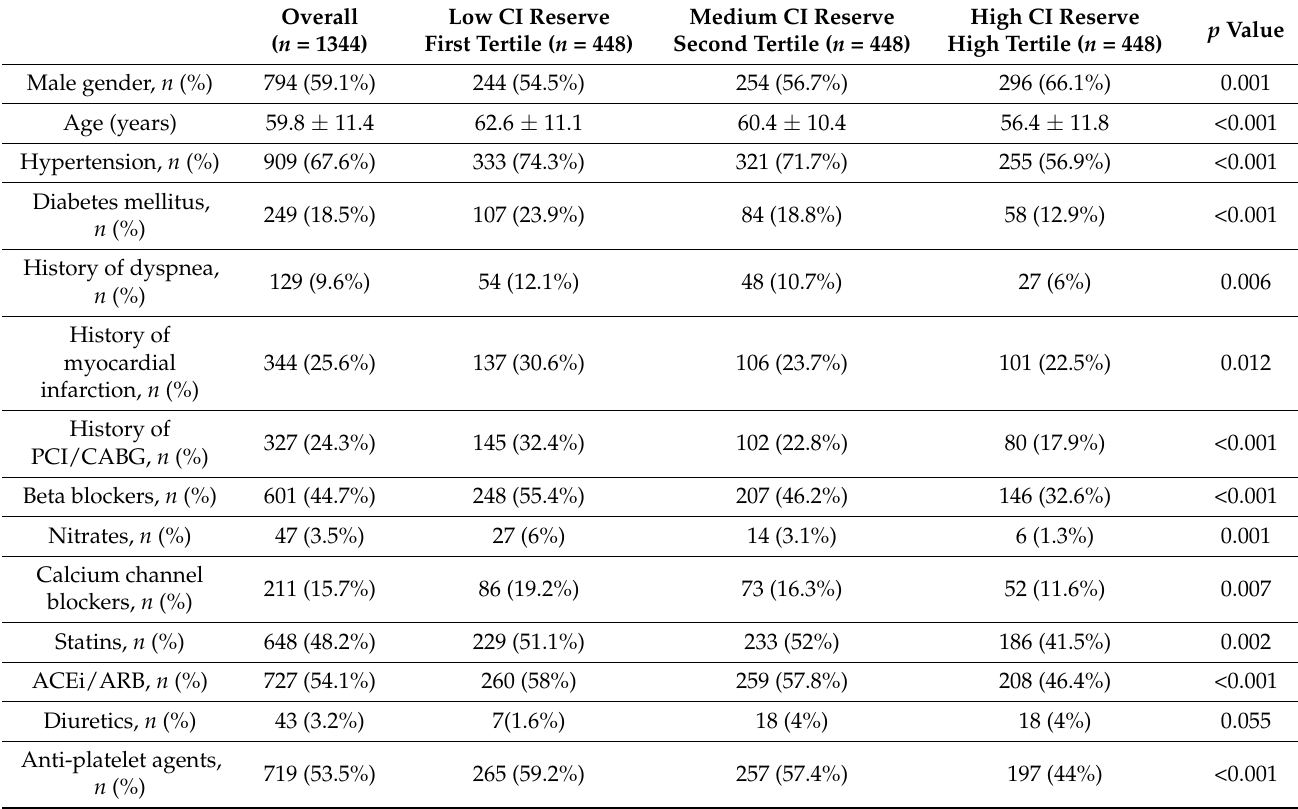
Table 1. Study patients and classes of cardiac